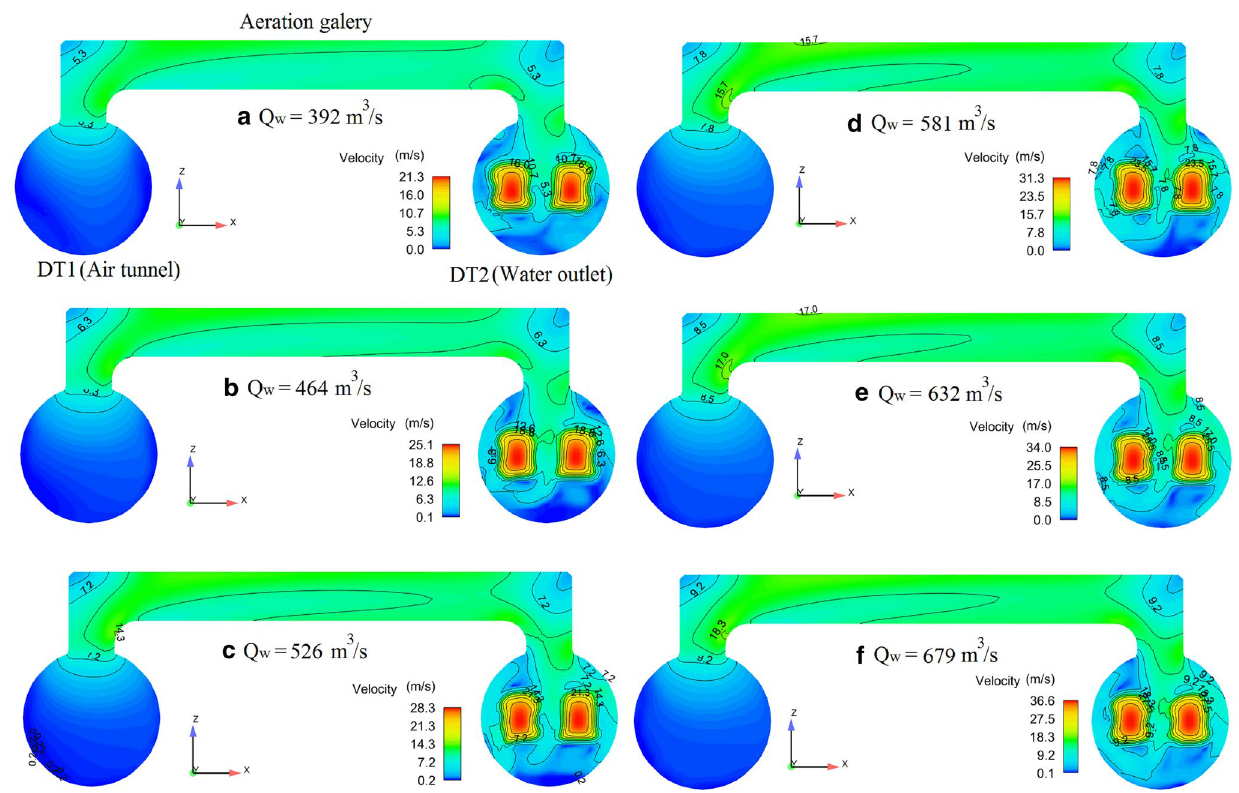
Fig. 7 Air velocity contours of prototype for different water discharges along aeration gallery Fig. 8 Cross sections along the aeration